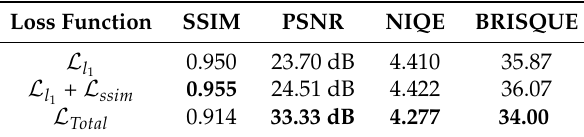
Figure 7. Effects of different loss function for the inpainter network: From left to right, input image I mic with microphone region provided by the user, results with l 1 reconstruction loss, L l , only, results 1 + L L perc . with joint loss of l 1 and SSIM , L l ssim , and the result with additional 1 Table 2. Quantitative evaluation for the ablation study on loss function in term of Structural SIMilarity (SSIM), Peak Signal to Noise Ratio (PSNR), Naturalness Image Quality Evaluator (NIQE), and Blind/Referenceless Image Spatial Quality Evaluator